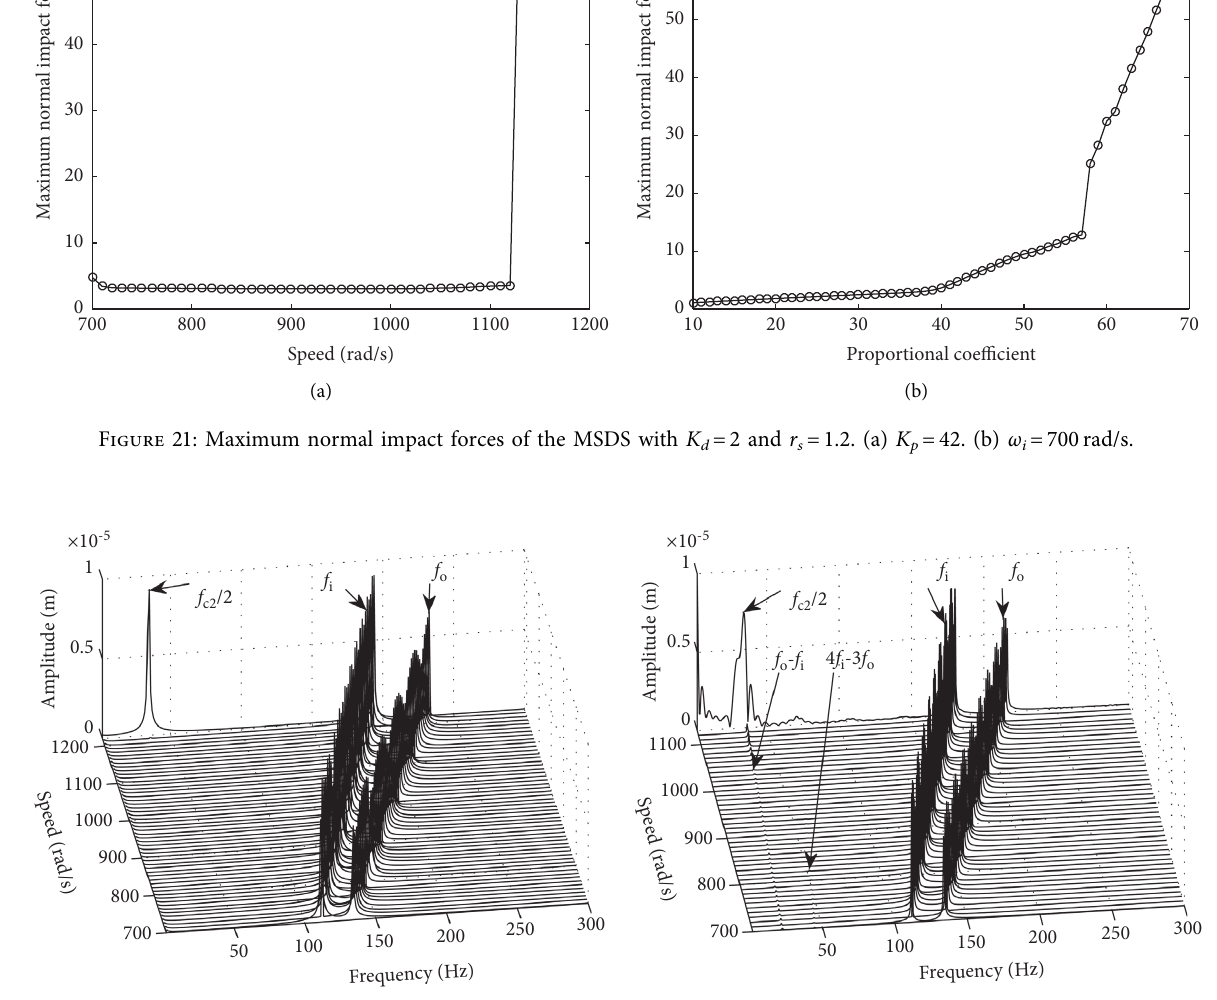
� 10, K � 1.2 and r � 1.2. (a) No rubbing. (b) Rubbing. p d s